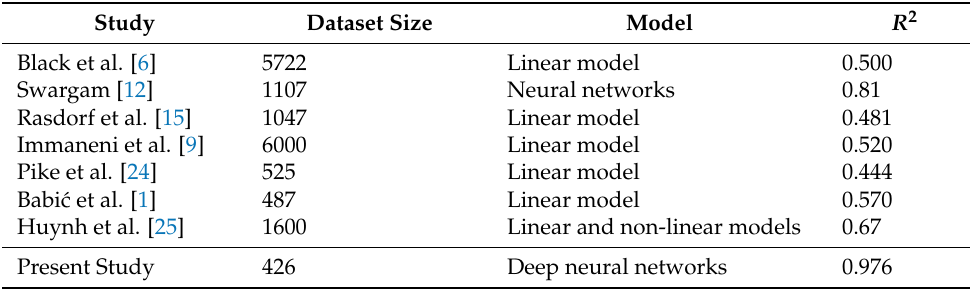
Table 10. Model performance with reference to previous